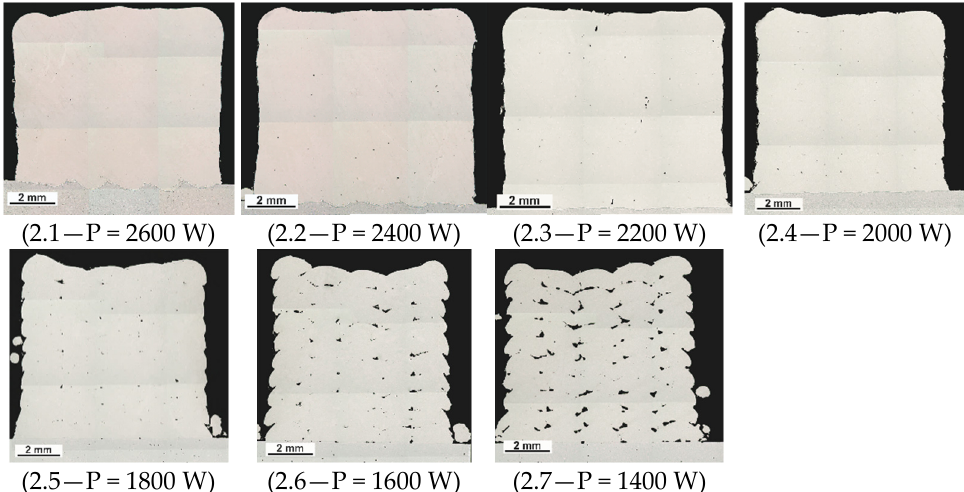
Figure 5. The thin sections of the samples (second series), laser power in the range of P = 2600 W ( 2.1 ) to P = 1400 W ( 2.7 ).